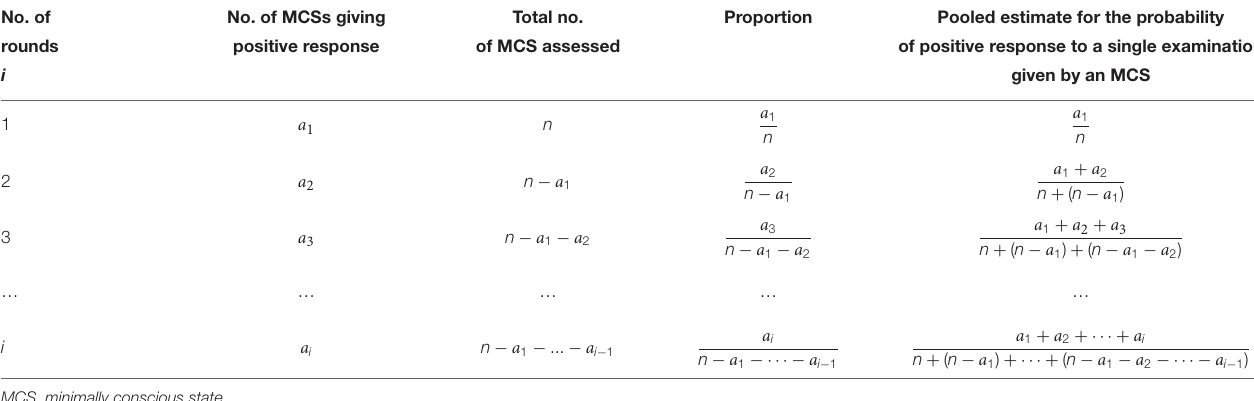
TABLE 2 | Estimation for a total number of MCS patients and their probability of giving positive response to a single examination. No. of No. of MCSs Estimated total Estimated probability of positive response to a rounds giving positive response no. of MCSs single examination given by an